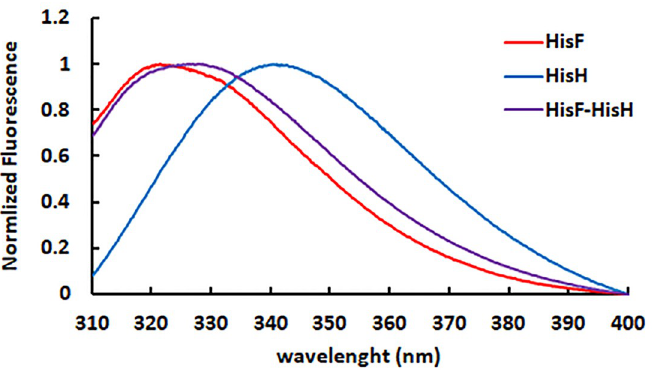
Fig 2. Effect of the dimerization on the HisF and HisH intrinsic fluorescence. The normalized spectra of HisF (red), HisH (blue) and HisF-HisH heterodimer (purple) present maximum fluorescence intensities at 321, 341 and 326 nm,